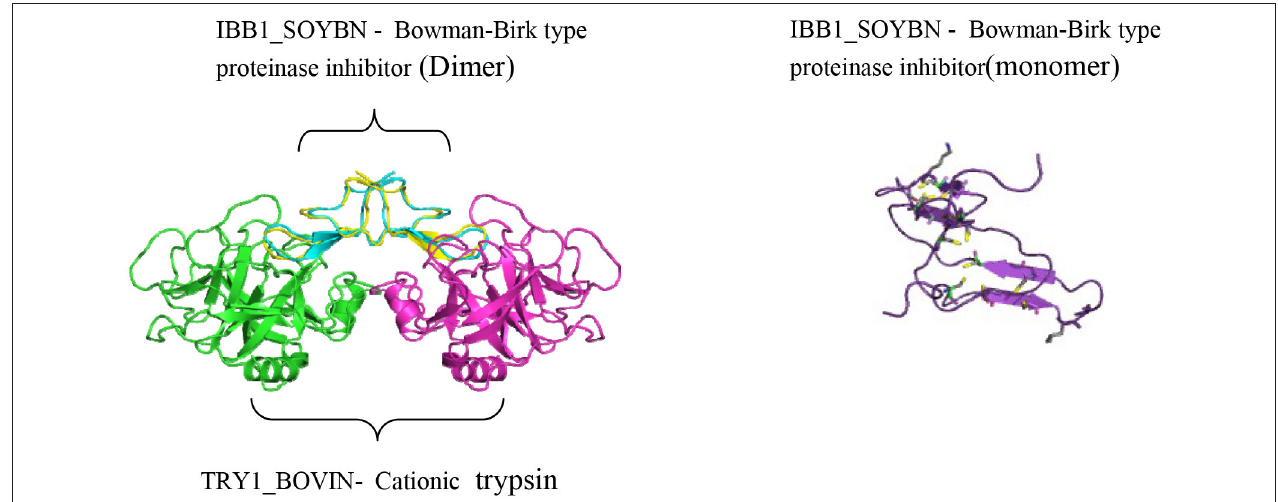
FIGURE 1 | Crystal structure of cancer chemopreventive Bowman-Birk inhibitor from Soybean in a ternary complex with bovine trypsin (PDB id: 1d16r) ( Koepke et al., 2000).